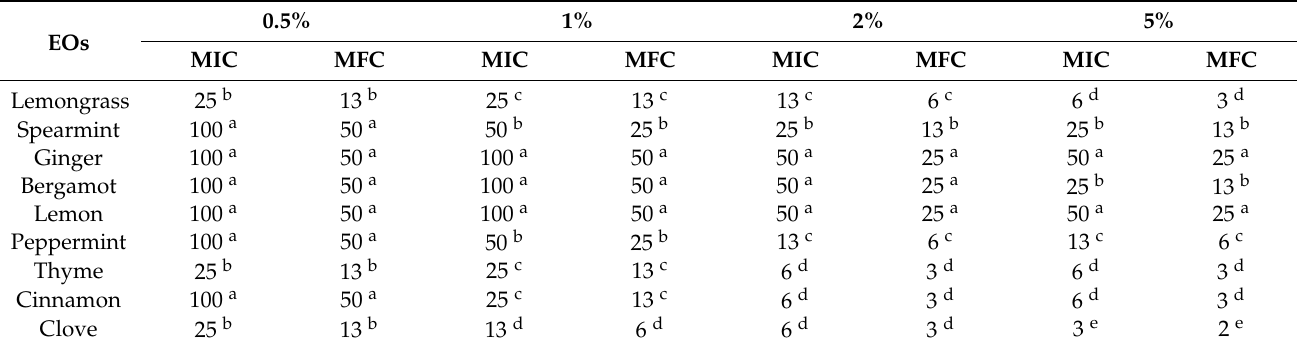
Values are mean ± standard deviation (n = 6). Different superscripts within the same column followed by different letters (a–e) indicate a significant difference ( p < 0.05). EOs: essential oils; MIC: minimum inhibitory concentration; MFC: minimum fungicidal concentration. MIC and MFC values present the concentration of EOs in µ g/ 100 µ